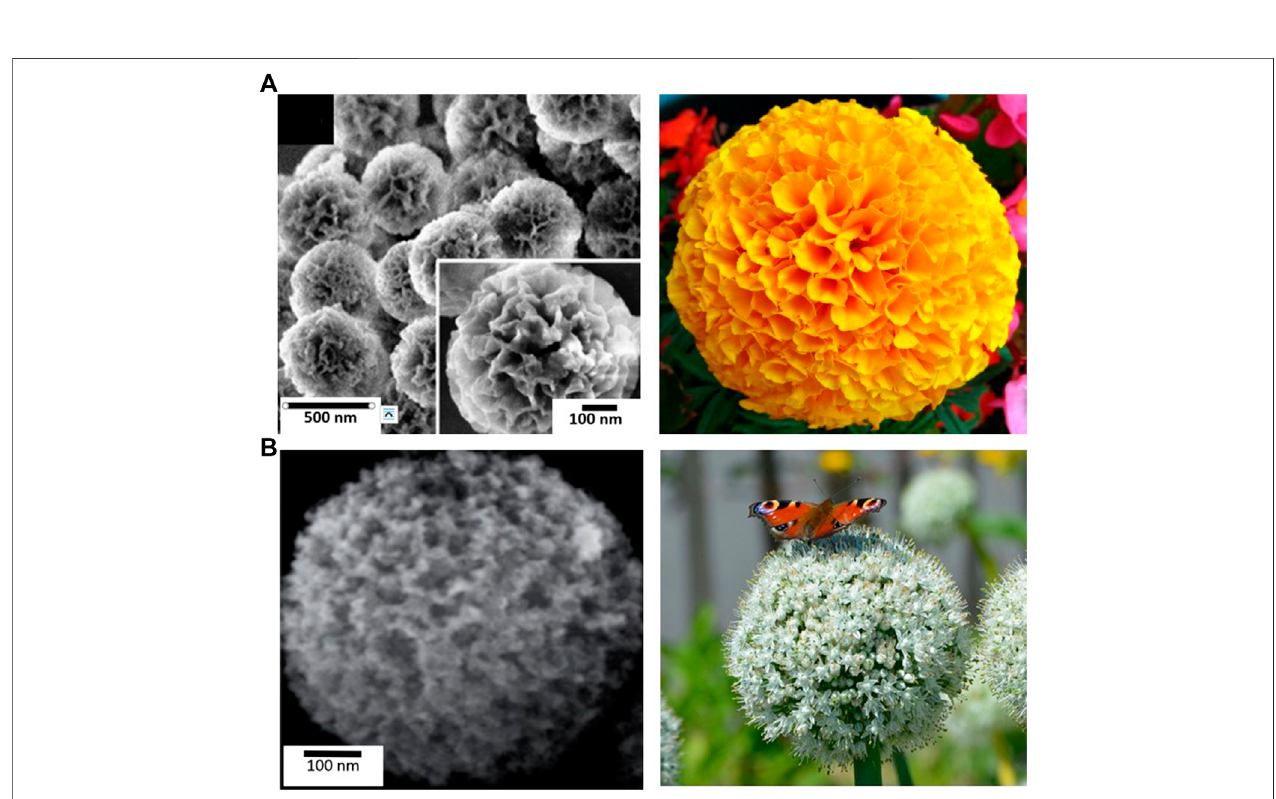
FIGURE 4 | Examples of ceramic nanostructured meso/macroporous hierarchical spheres. (A) TEM of functionalized wrinkled silica spheres with meso/ macroporoushierarchicalsystem(ReprintedbypermissionfromJ.PorousMater.28,261 – 269(2021)Copyright©2020,SpringerScienceBusinessMedia,LLC,partof Springer Nature) compared to the Cempasúchil ( Tagetes erecta ) fl ower (Pixabay license for the public domain. Available on: https://pixabay.com/photos/mexican- marigold-orange- fl ower-plant-5540037/). (B) SEM of meso/macroporous hierarchical SiO 2 spheres decorated with TiO 2 NPs (©2019 the chapter is